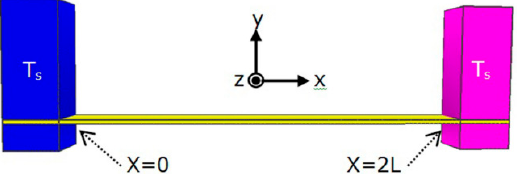
Figure 2. Conventional single beam with length 2L connected to pads with ambient temperature Ts